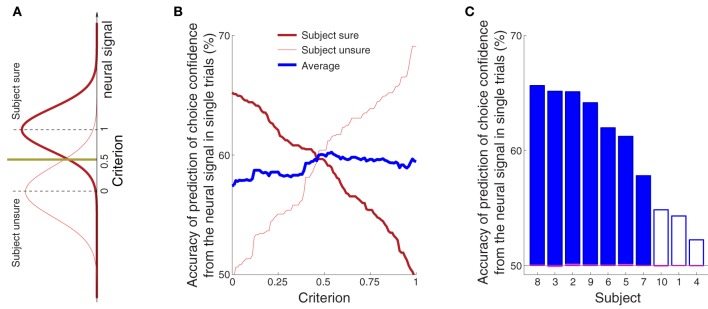
The confidence in a forthcoming button press choice predicted from the neural signal in single trials. (A) The sure and unsure choices of a button press are associated with sure and unsure distributions of values of the neural signal. A new, independent value of the neural signal is compared to a criterion value. The criterion is set by the experimenter and takes a value between 0 (value equal to the median of the unsure distribution) and 1 (value equal to the median of the sure distribution). The scheme predicts that a subject is going to be sure (unsure) if the neural value is higher (lower) than the criterion. (B) Average prediction accuracy as a function of the criterion, separately for sure (thick red) and unsure (think red) choices, and their average (thick blue). If the criterion is moved to a lower value, such that it accounts for a larger portion of the sure distribution in (A), the ability to predict that a subject was sure will be higher (thick red), and the ability to predict unsure will be close to chance (thin red). Reversely, pushing the criterion to a higher value, such that it covers more of the unsure distribution, will improve the ability to predict “unsure” (thin red) and decrease the accuracy of predicting “sure” (thick red). (C) Average prediction accuracy in each subject. The criterion value was set to 0.55 [the maximum average prediction accuracy taken from the blue curve in (B)]. The accuracy using the same classifier when the sure and unsure class labels are drawn randomly (and so when the relationship between the neural signal and confidence is distorted) falls to chance (50%, range 49.9–50.1%; see magenta bars). The filled blue bars represent values that are significantly (p < 0.05) higher than the chance accuracy of 50% (Section 2).